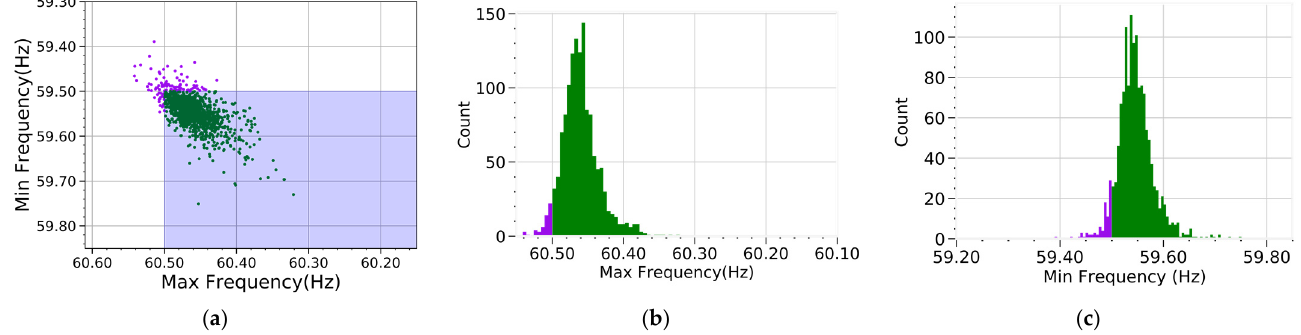
Figure 12. Max. & Min. frequency and histograms of Island 1 and Island 2: N = 10. (Purple: outside secure region, green: inside secure region, shaded area: secure region). ( a ) Max. and Min. frequency; ( b ) Max. frequency histogram in Island 1; ( c ) Min. frequency histogram in Island 2.